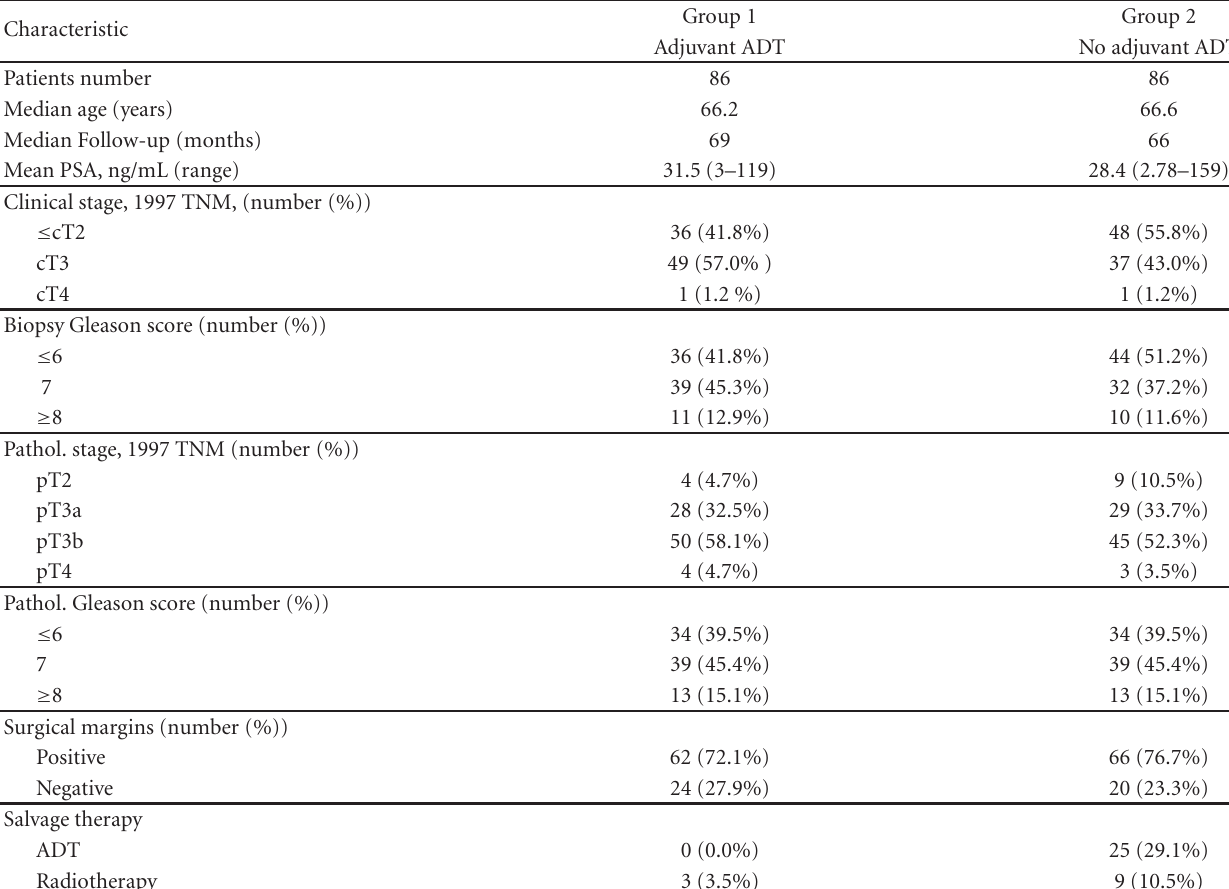
Table 1: Preoperative and postoperative characteristics of the 172 matched patients.